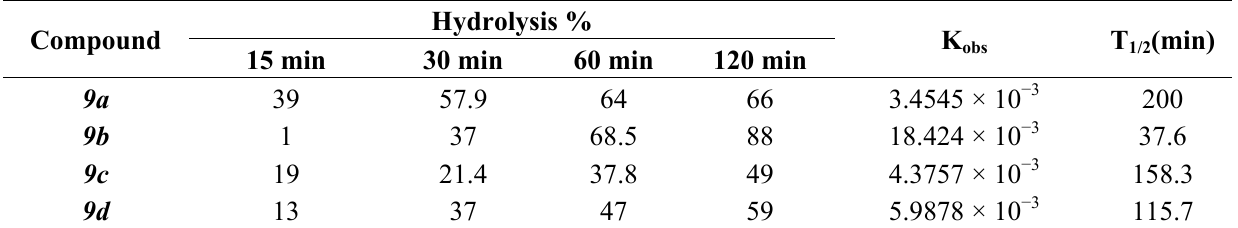
Table 2. The kinetic data for the plasma hydrolysis of compounds 9a–d